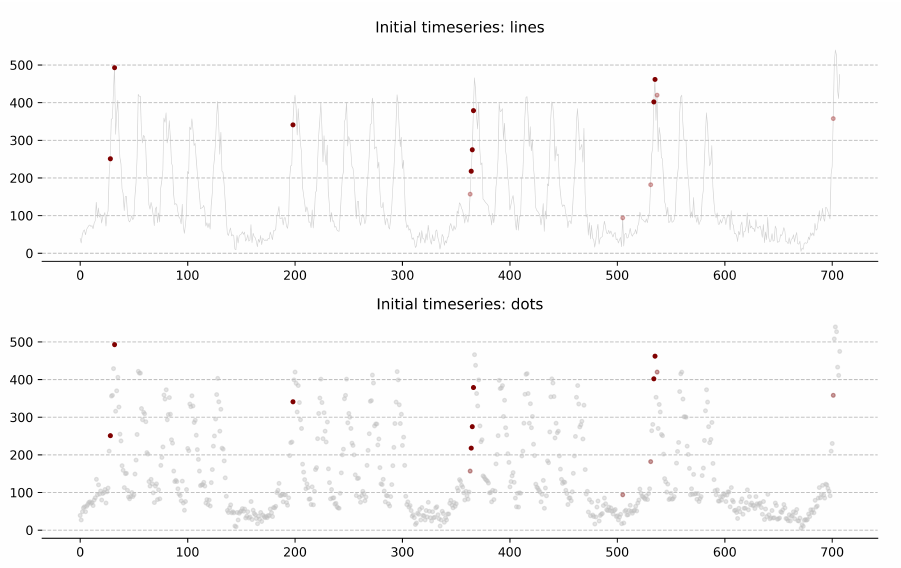
Figure 13. Numenta Anomaly Benchmark time series with a seasonal